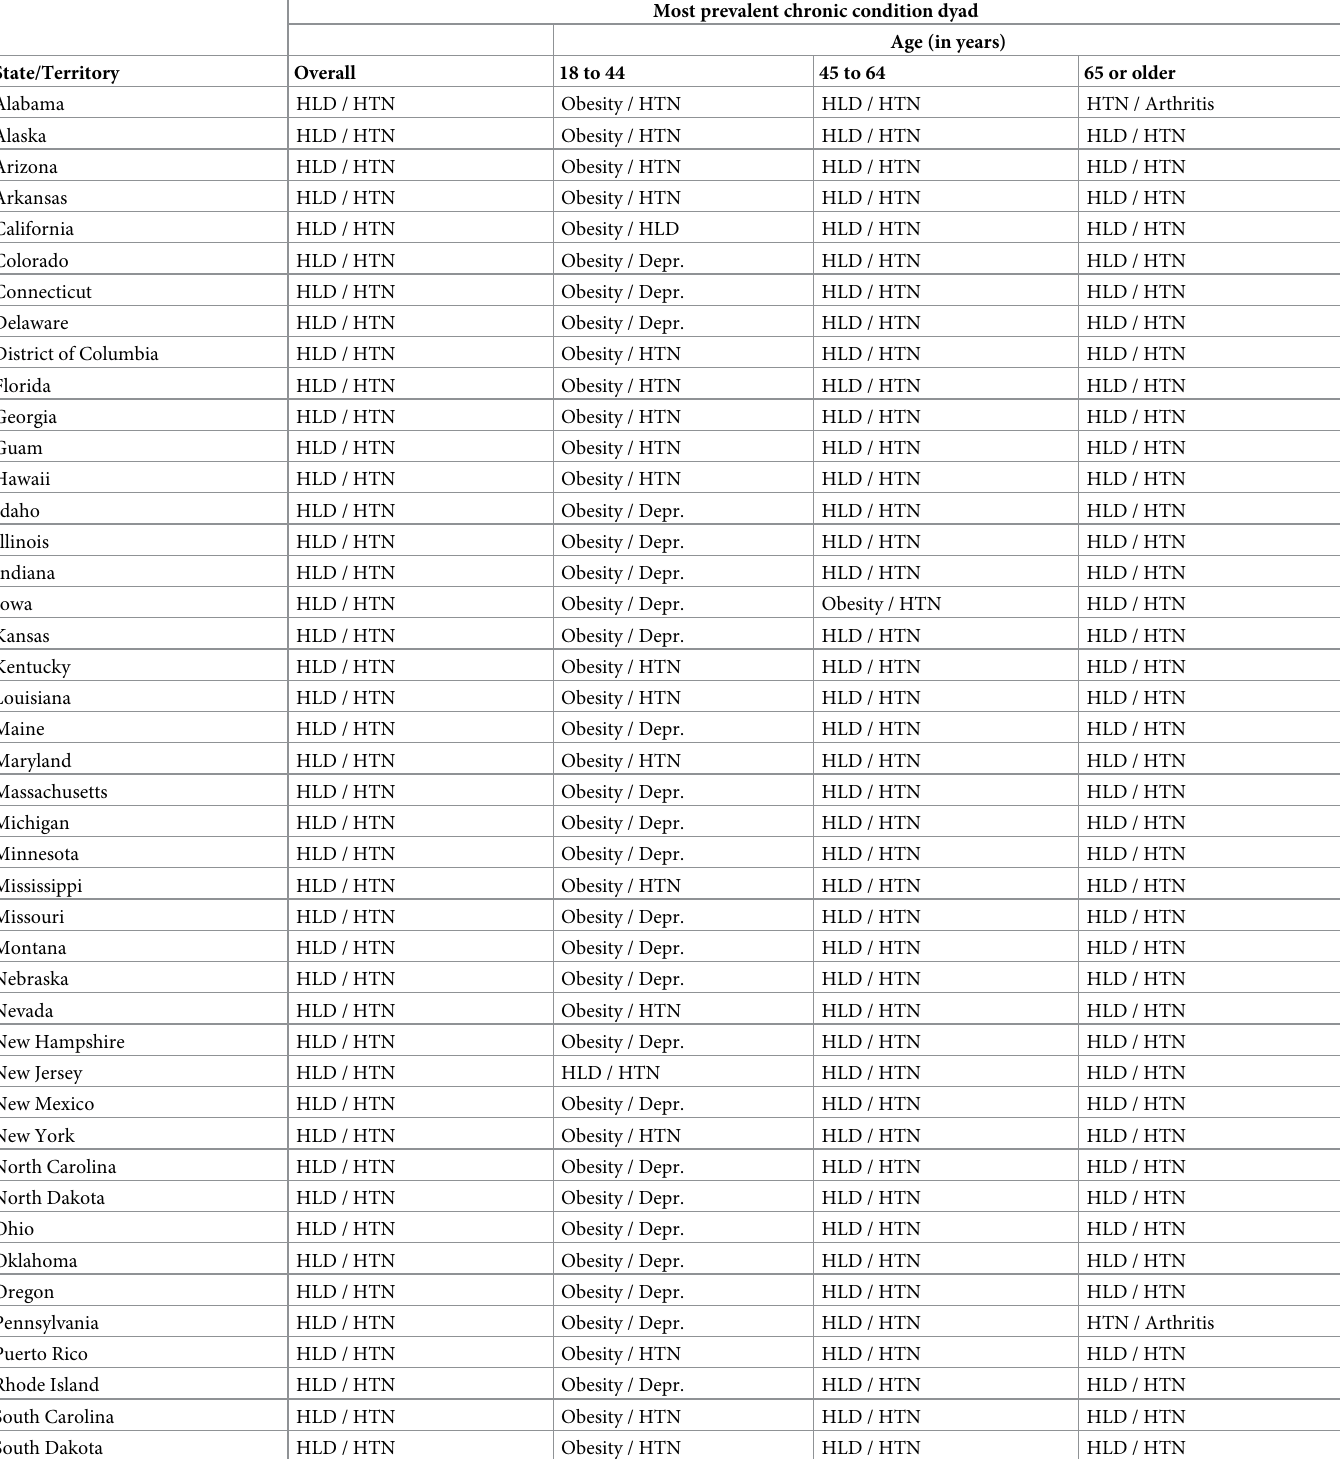
Table 2. Most prevalent chronic condition dyads among adults aged � 18 years, by state or territory and age—Behavioral Risk Factor Surveillance System, United States,